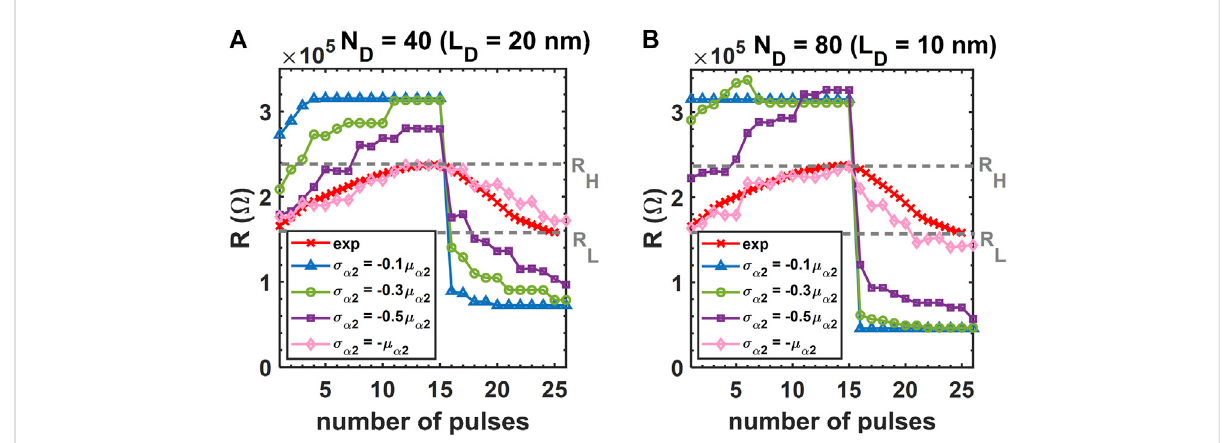
FIGURE 5 SimulatedandexperimentaldepressionandpotentiationresponseoftheWO x -basedFeFETofFigure1asafunctionofthenumberofelectrical pulses at different standard deviations σ α 2 for (A) N D = 40, L D = 20 nm; (B) N D = 80, L D = 10 nm domain con fi gurations. The writing pulse train increasesfrom1.3to2.7 Vfordepressionandthendecreasesfrom − 1.5to − 2.5 Vforpotentiation,withastepsizeof±0.1 V.Theexperimental R H and R L values are both indicated. They correspond to the resistance at the beginning of the pulse sequence ( R L ) and at the end of the depression part ( R H